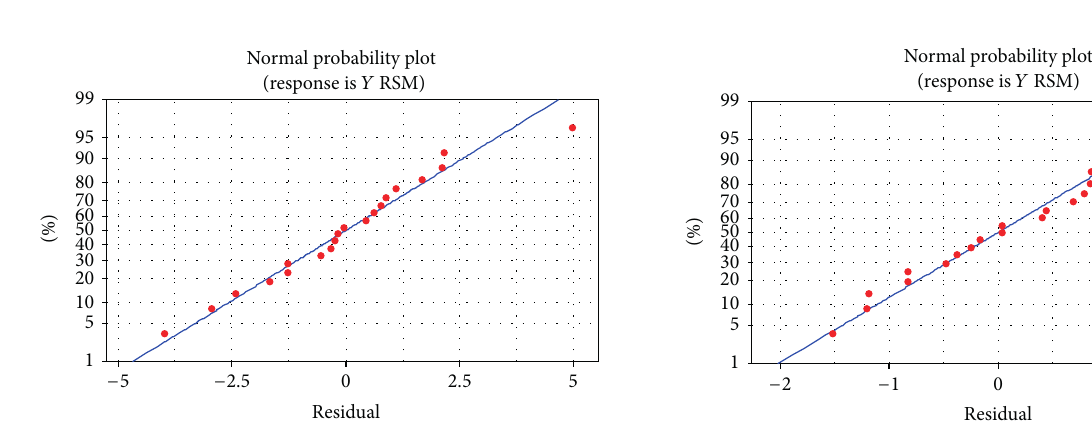
Figure 3: Residual plot with outlier. Figure 4: Residual plot without